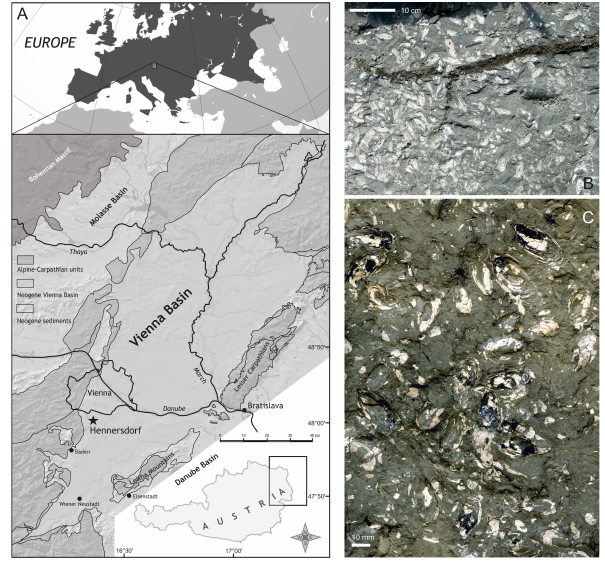
Fig. 1. (A) Geological map of the Vienna Basin showing the posi- tion of the investigated core at Hennersdorf. (B) A dreissenid pave- ment in the Hennersdorf pit during field work (with a fossil twig). This pavement can be followed over more than 400m distance from the outcrop area. (C) Moderately dense coquina of Sinucongeria primiformis . The shells are articulated and the sediment fill of the valves is coated with pyrite indicating rather abrupt installation of dysoxic conditions killing off the